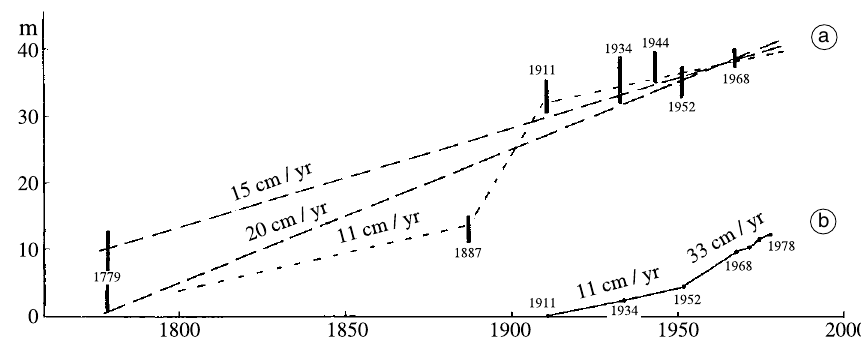
Fig. 7a,b. Secular movements of Iwojima (after Kaizuka et al. , 1985). a) Secular change in height (above sea level) of the isthmus at the north of SU; b) Accumulated uplift and annual rates after